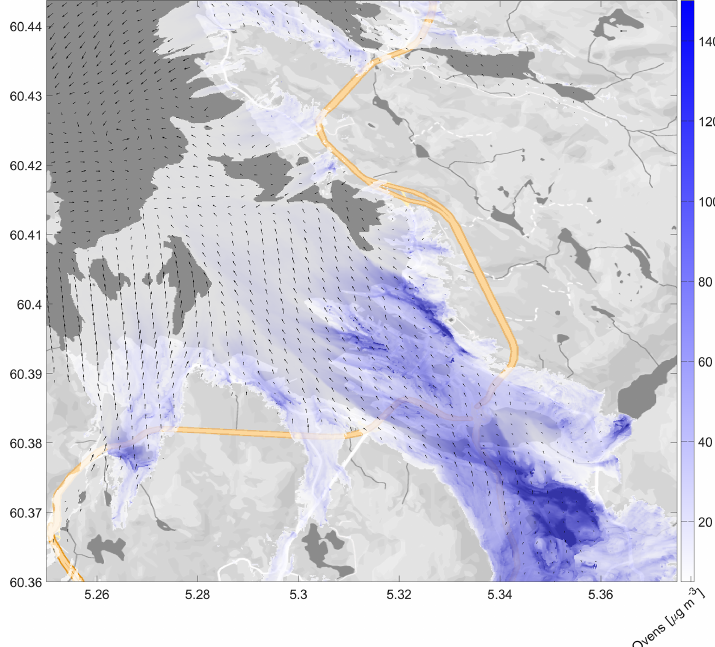
Figure 6. The same as in Fig. 5 but for the PM 2 . 5 concentration pattern. The emission source of PM 2 . 5 here was associated with the wood- burning fireplaces. The concentrations are given by semi-transparent colour shading overlaying the grayscale land and water surface taken from map data ©2019